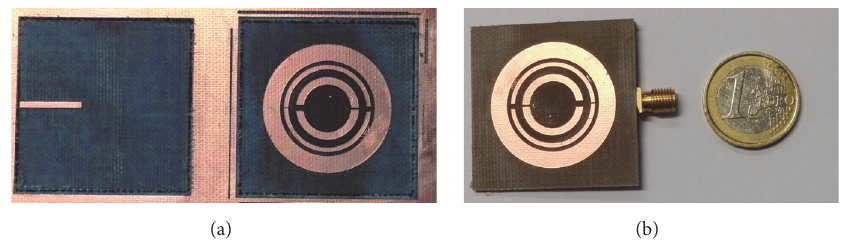
Figure 2: Photo of the designed antenna shown in Figure 1: (a) top and bottom layers; (b) assembled antenna.